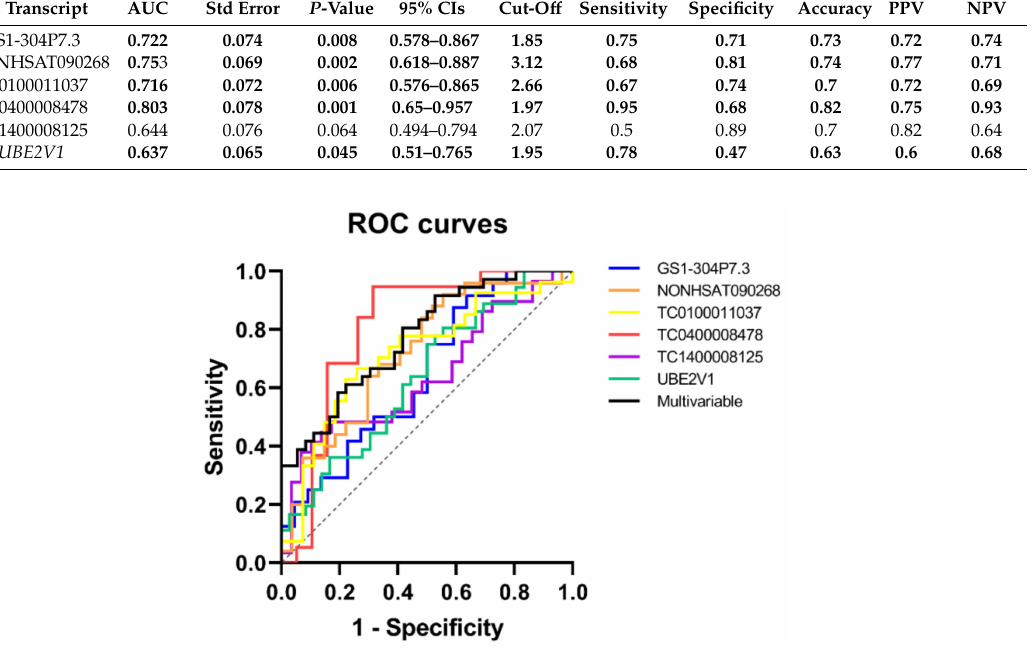
Figure 2. Univariable and multivariable ROC curves computed on plasma expression levels of di ff erentially expressed (DE) transcripts.